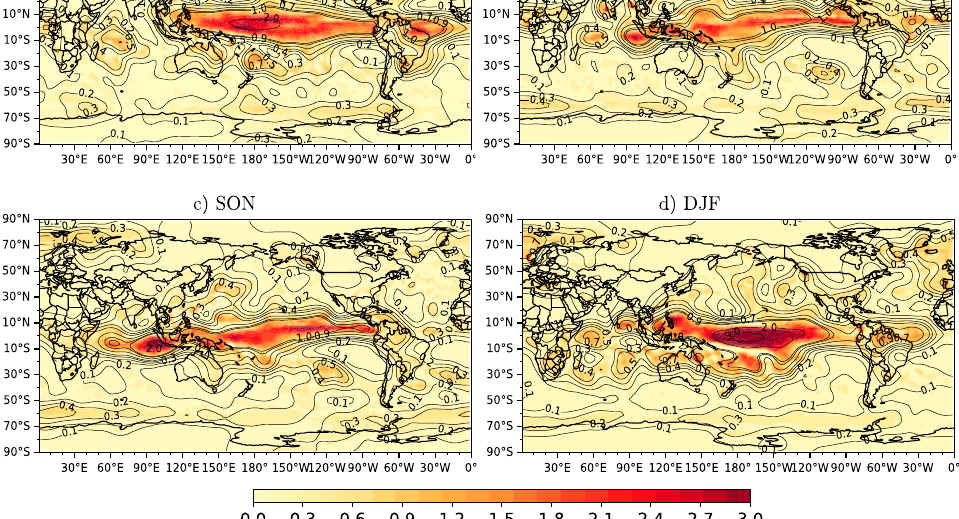
Figure 1. Predictable component standard deviation of GPCP precipitation (mm/day).